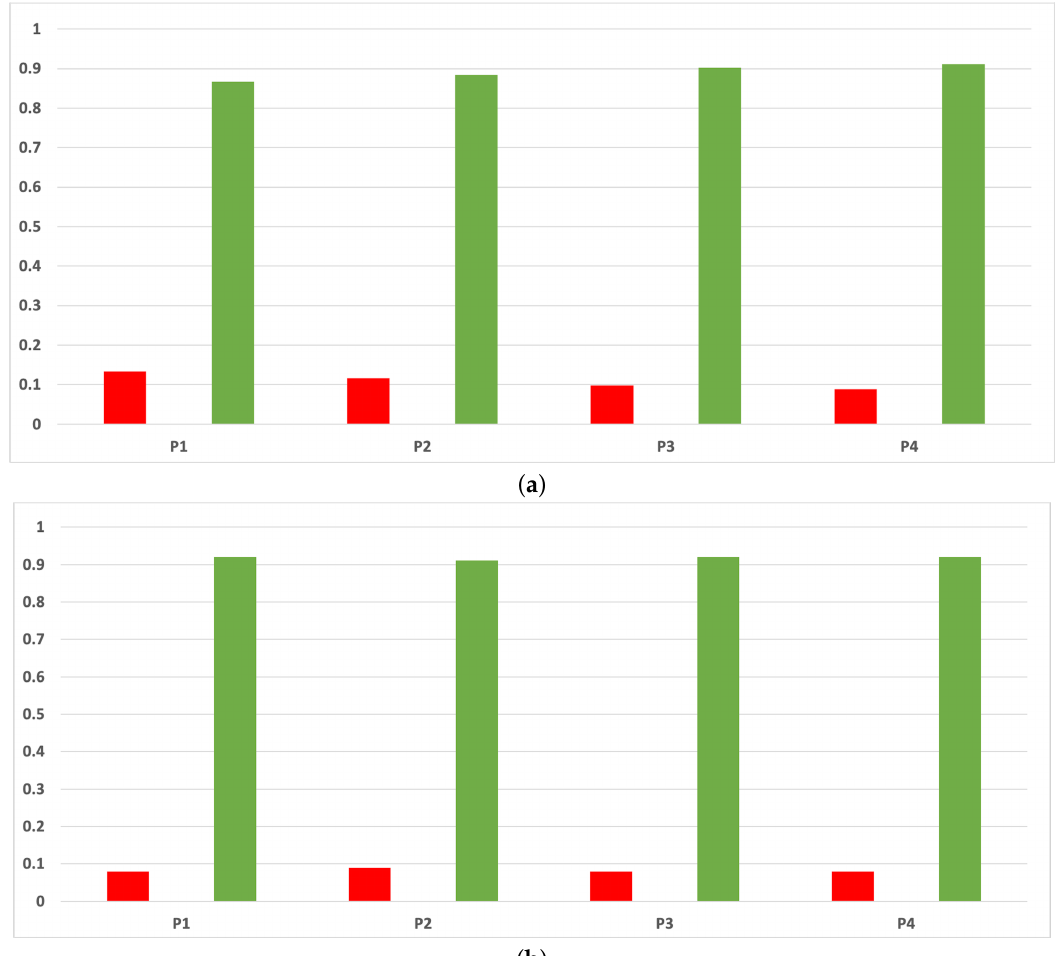
Figure A10. Experiment 1: consistency per partition (accuracy and time complexity). ( a ) Rate of validity per partition in DT. ( b ) Rate of validity per partition in